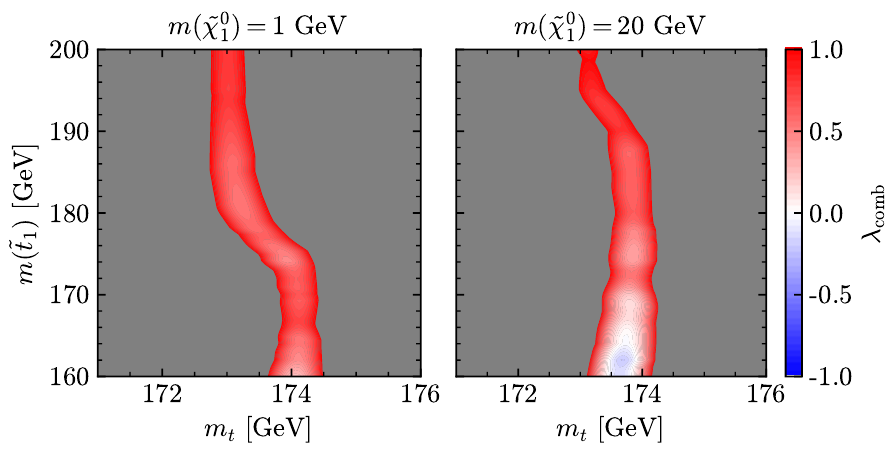
Figure 12 . Values of the test statistic given in eq. (E.1), which is designed to compare the goodness of (cid:12)t for the SM alone versus the BSM scenario studied here. The red regions provide a (cid:12)t which is within 1 (cid:27) of the SM alone hypothesis, the white regions give the same quality of (cid:12)t as the SM, and the blue regions give a better (cid:12)t than the SM alone. The overall best (cid:12)t is at m t = 173 : 7 GeV and m ( ~ t ) = 162 : 0 GeV for the panel with m ( ~ (cid:31) 0 1 ) = 20 GeV; the (cid:12)t to the top mass 1